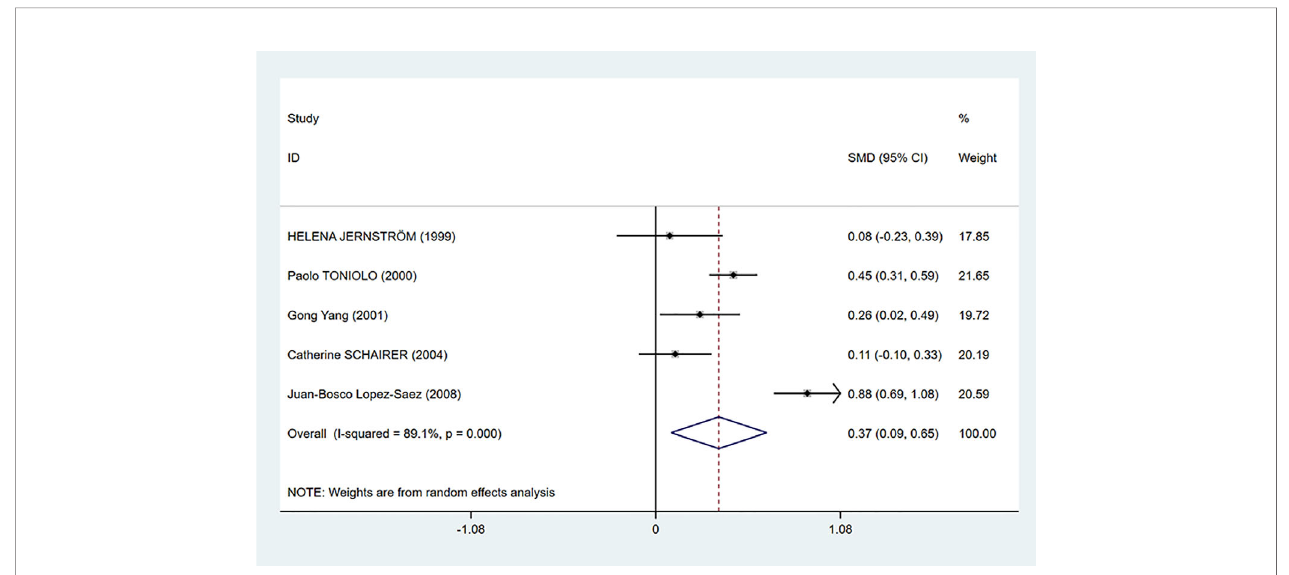
FIGURE 2 | Overall forest plot of meta-analysis on the association between C-peptide and breast cancer risk. The size of the square box is proportional to the weight that each study contributes in the meta-analysis. The overall estimate and CI are marked by a diamond. Summary estimates were analyzed using a random- effects model. Zero is not included in this con fi dence interval, and diamond is on the right of zero, which indicates that C-peptide levels were positively associated with breast cancer